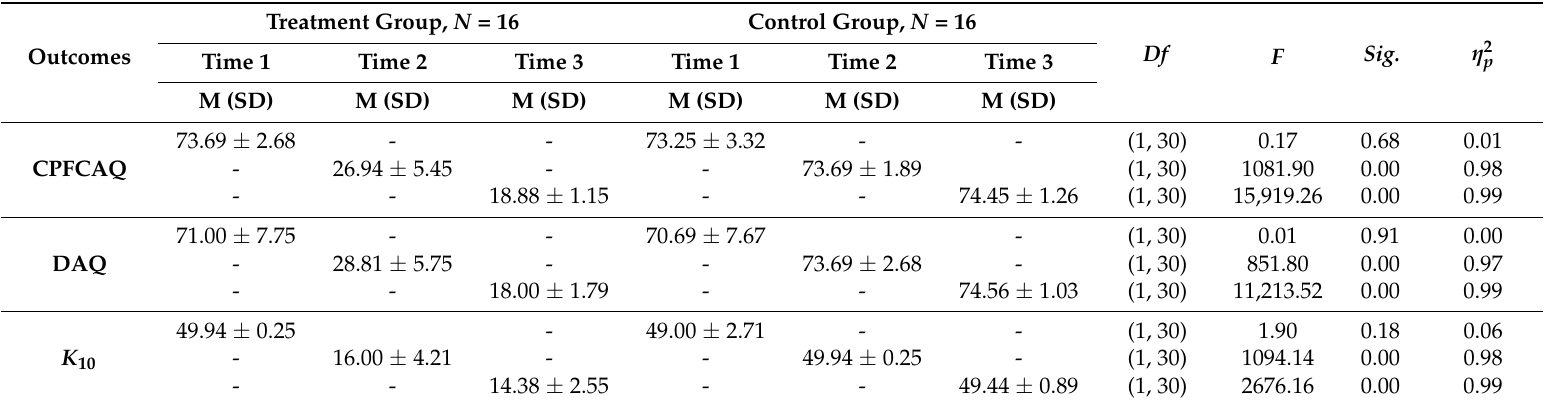
Table 2. Summary statistics from repeated measures analysis of variance (ANOVA) on cancer patients’ level of problematic assumptions, death anxiety, and psychological distress by treatment condition and time.